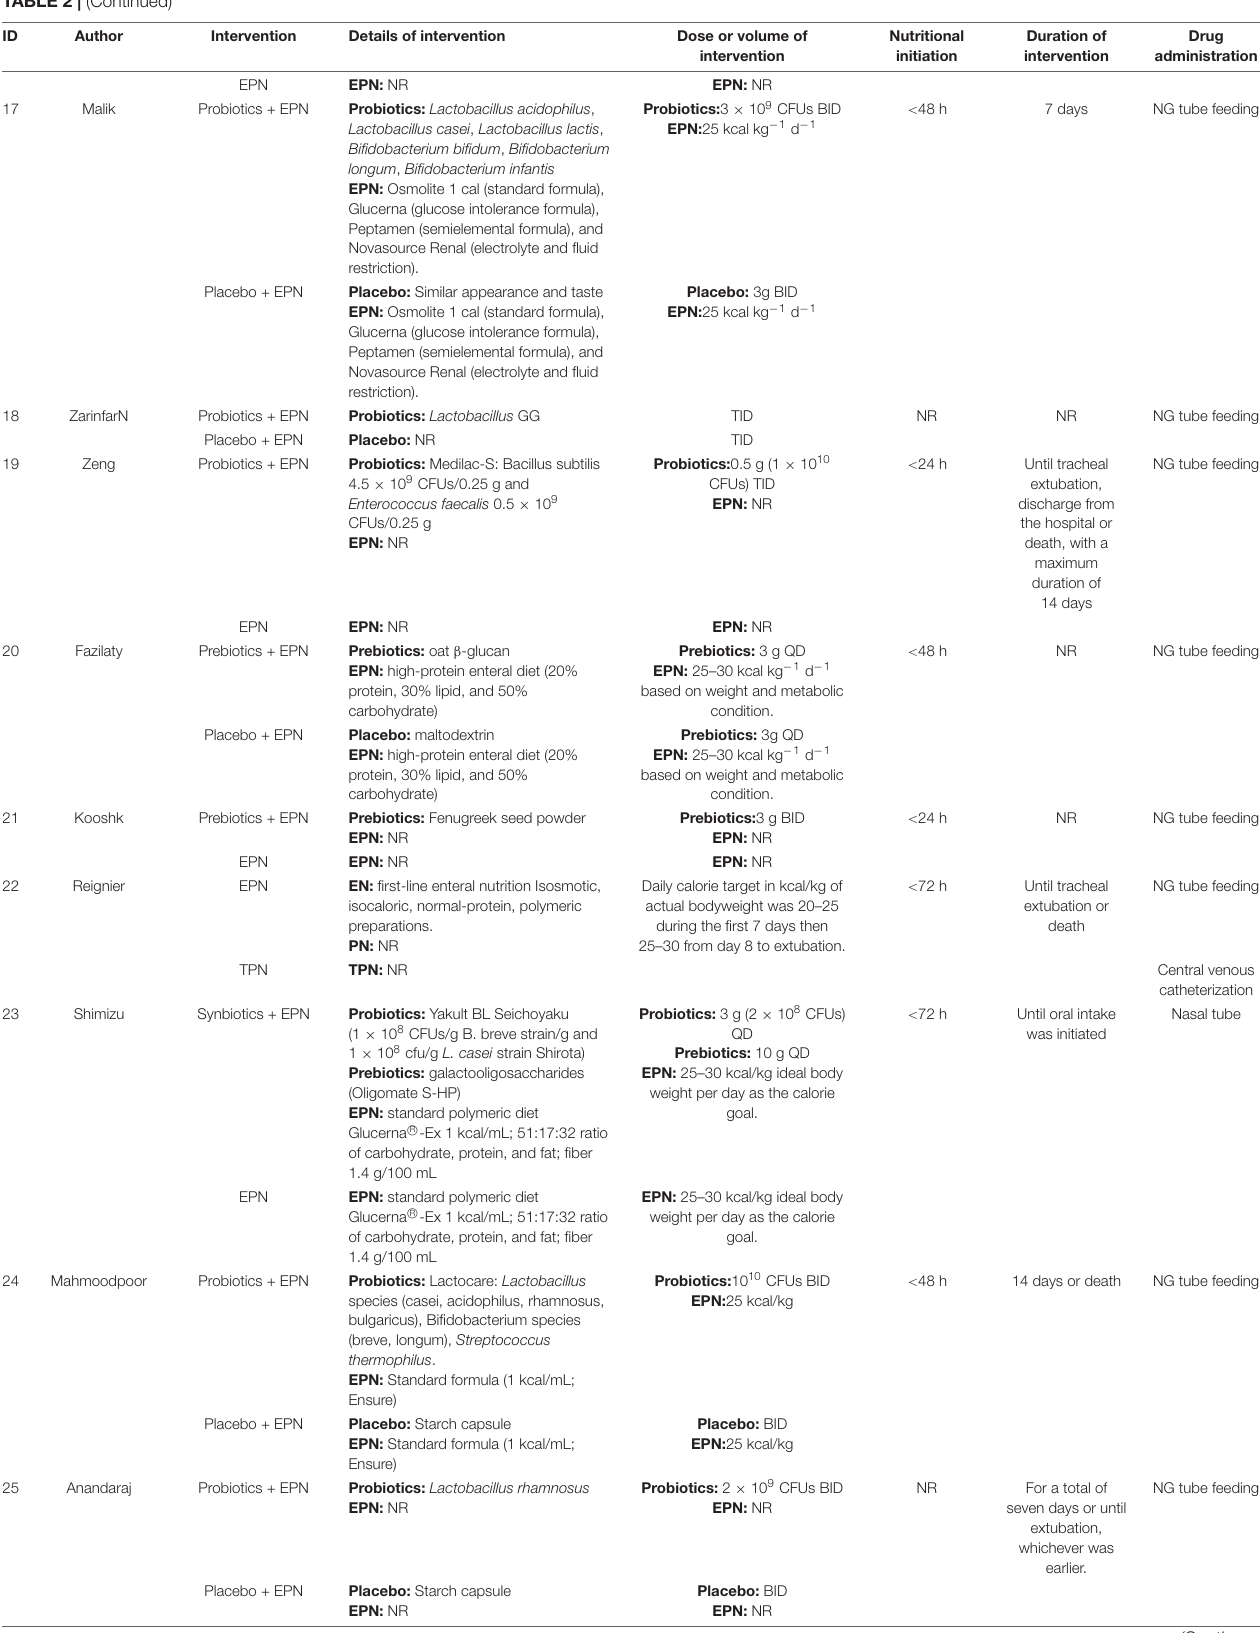
17 Probiotics + EPN Probiotics: Lactobacillus acidophilus ,